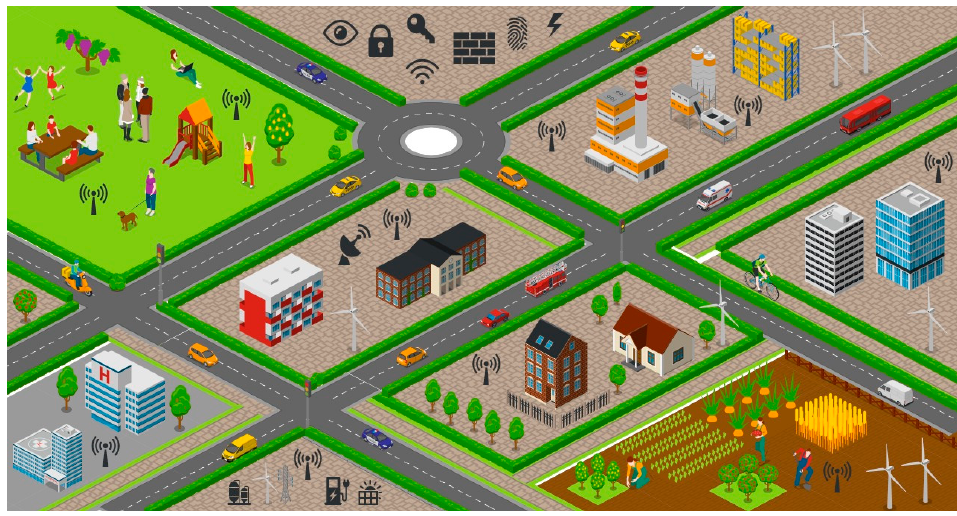
Figure 1. Smart city ecosystem.